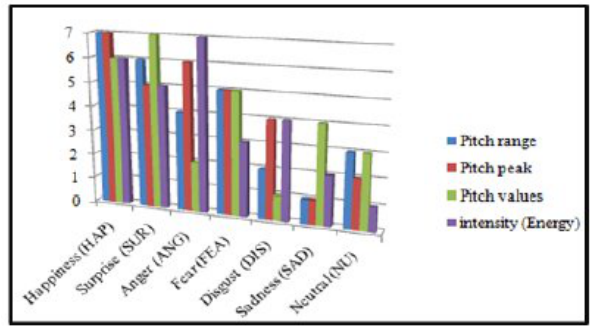
Fig. 20. Bar chart of the six basic emotions.